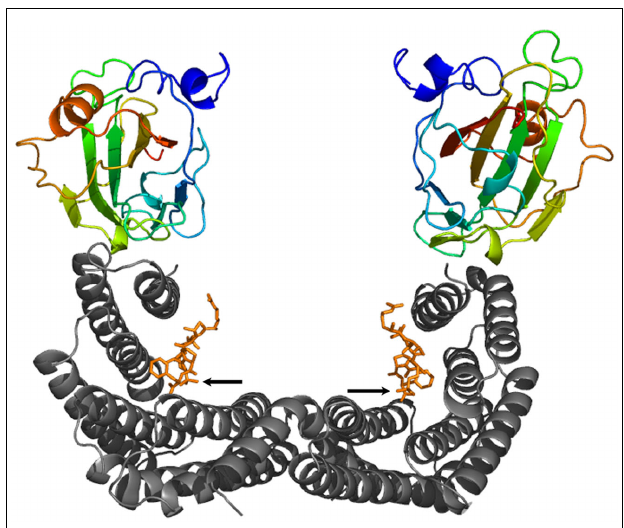
FIGURE 1 | Ribbon plot of a 14-3-3 dimer (gray) in complex with two phosphopeptides derived from the transcription factor OsFD1 (orange, the phosphorylated residue is indicated by an arrow, respectively) and two Hd3a proteins [color coded from the N-terminus (blue) to the C-terminus (red)] (Taoka et al., 2011). While binding of the OsFD1 phosphopeptides occurs in an extended conformation within the amphipathic groove of each 14-3-3 monomer, the “florigen” Hd3a attaches to the “outside” of the groove,